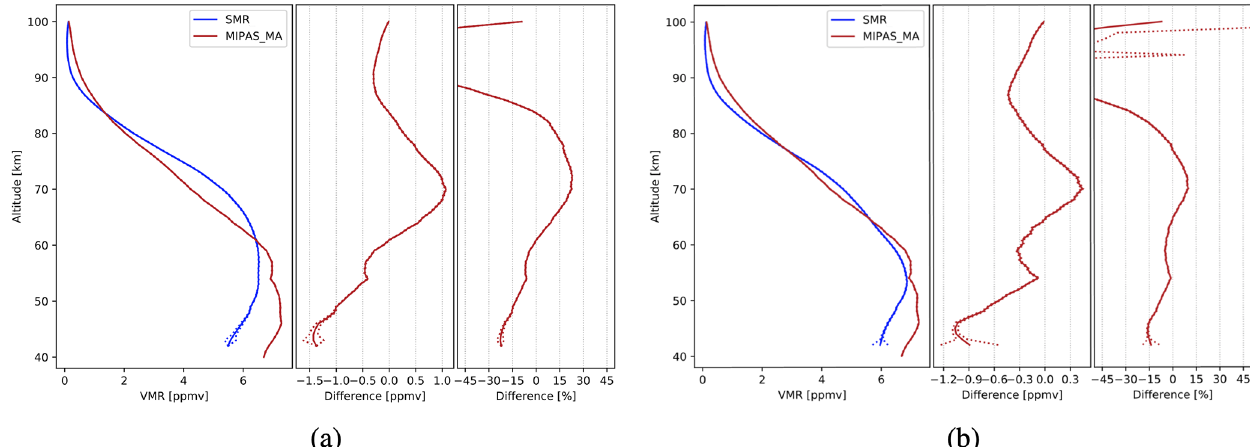
Figure 8. Comparison of SMR H 2 O profiles, from FM13 (a) and FM19 (b) , with those from MIPAS middle atmosphere mode retrievals. The data plotted are global averages over the time periods indicated in Table 2. Figure characteristics are the same as in Fig.